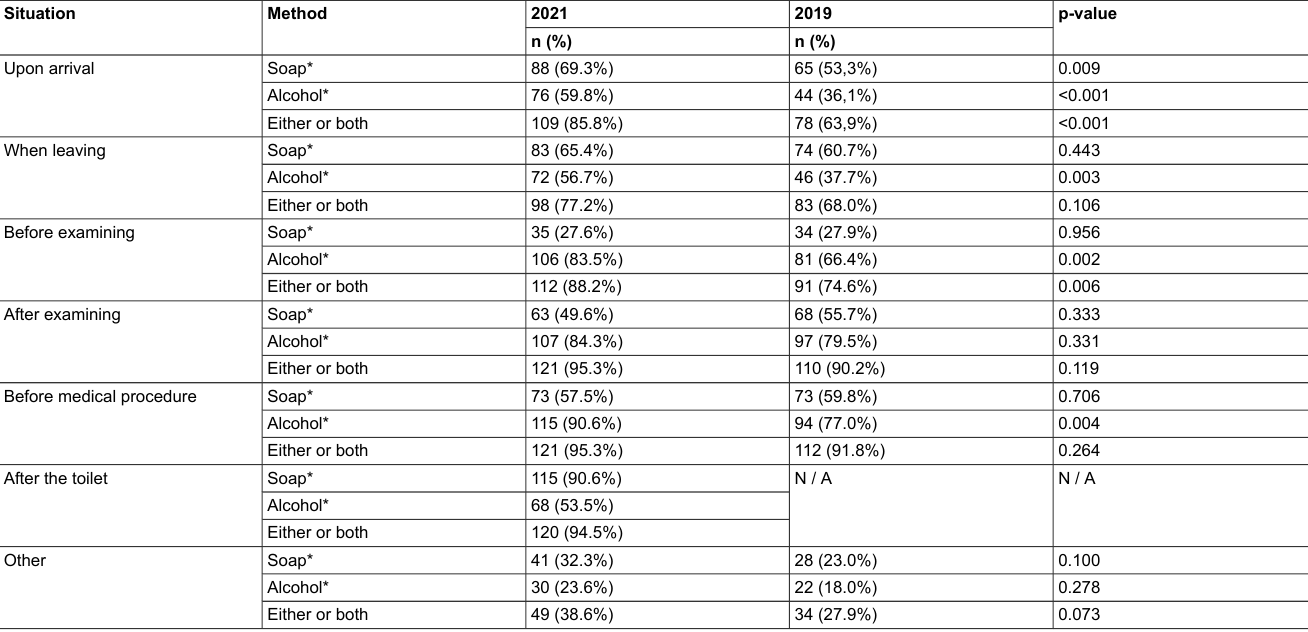
Table 4: Hand hygiene of reporting physician in the Sentinella network in 2021 and 2019 (127 and 122 answering practices,